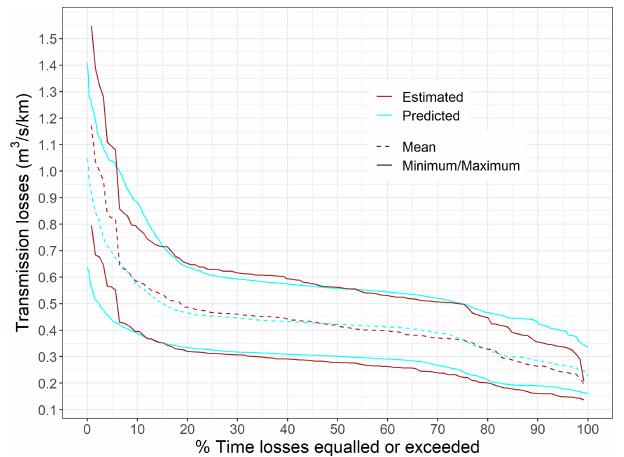
Figure 14. Wetted river length as a function of the river discharge, only shown for data points collected during river drying phases (more than 60h after a peak